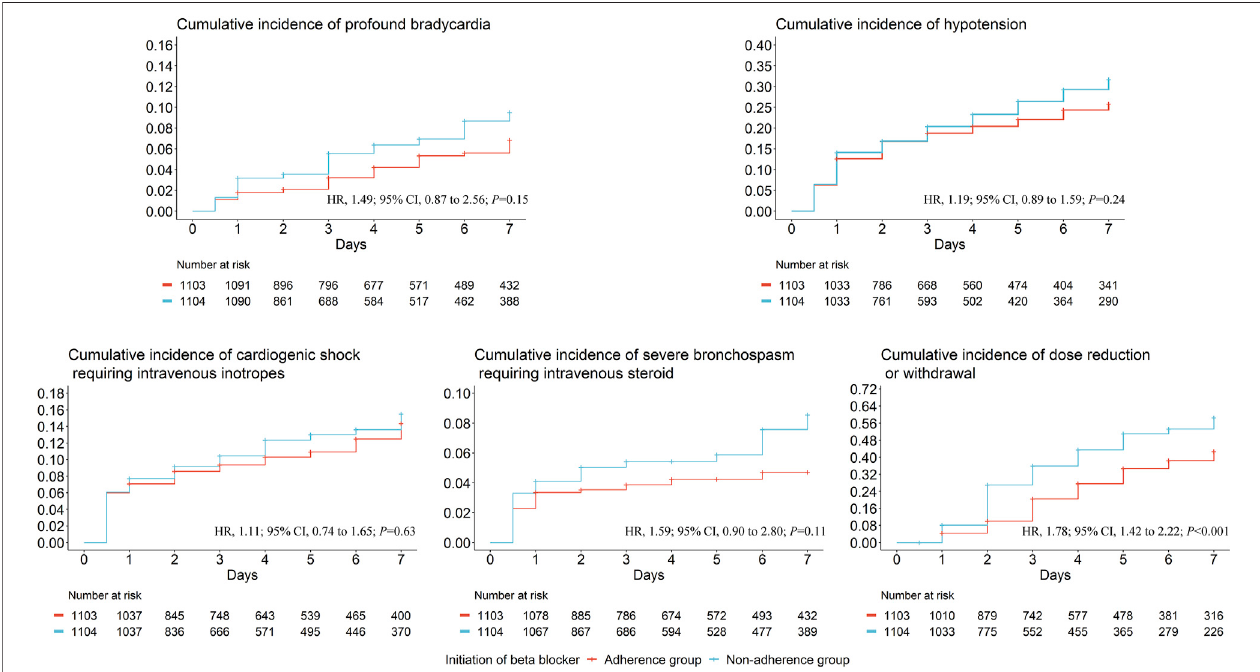
FIGURE 2 | The IPW-adjusted cumulative incidence of each time-to-event adverse events. We derived propensity score for each patient using a multivariable logistic regression model, adjusting for age, sex, baseline heart rate, baseline systolic blood pressure, baseline N-terminal pro-B type natriuretic peptide, baseline left ventricular ejection factor, baseline estimated glomerular fi ltration rate, and Charlson Comorbidity Index.; Abbreviations: IPW, inverse probability weighting; HR, hazard ratio; CI, con fi dence interval. Days are calculated from the date of initiating beta blockers.